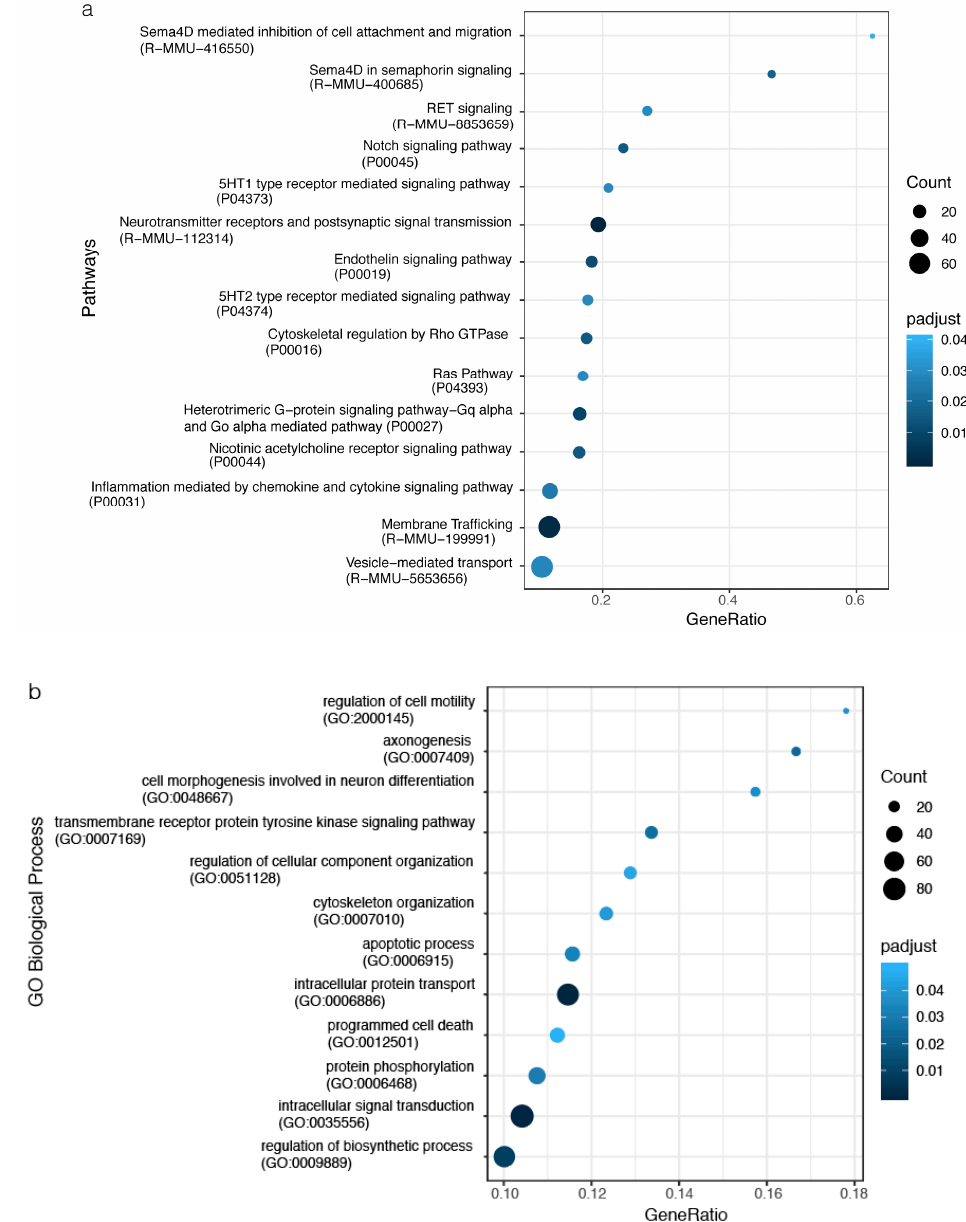
Figure 8. Dotplot of enrichment analysis in TS-STR compared to TS-SVZ. ( a ) Panther (P) and Reactome (R-MMU) pathways; ( b ) Gene Ontology Biological Process. p -adjusted < 0.05 was considered statistically significant.